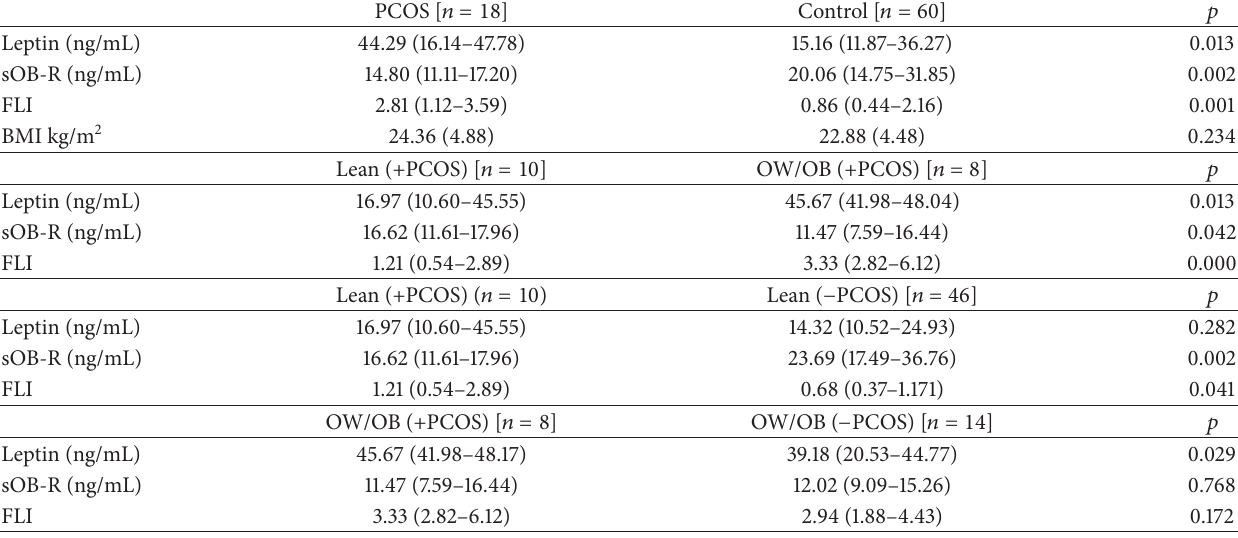
Table 2: Leptin levels (ng/mL), sOB-R (ng/mL), and LFI among PCOS subjects and in the presence/absence of overweight/obesity.